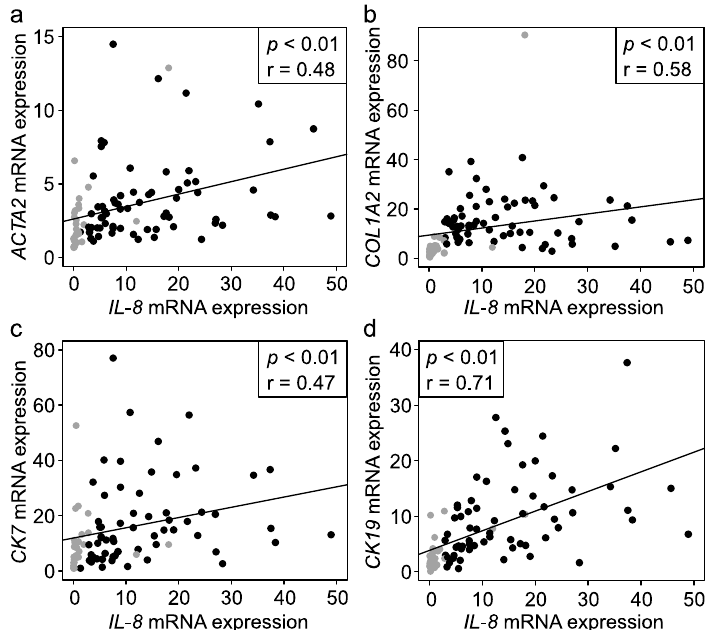
Figure 3. Correlations between liver IL-8 expression and transcriptional markers of fibrogenesis and cholangiocytes. Scatterplot for correlation between relative liver IL-8 mRNA expression and ( a ) ACTA2 ( b ) COL1A2 ( c ) KRT7 and ( d ) KRT19 . Black dots represent samples obtained at portoenterostomy (PE) and grey dots represent follow up samples.